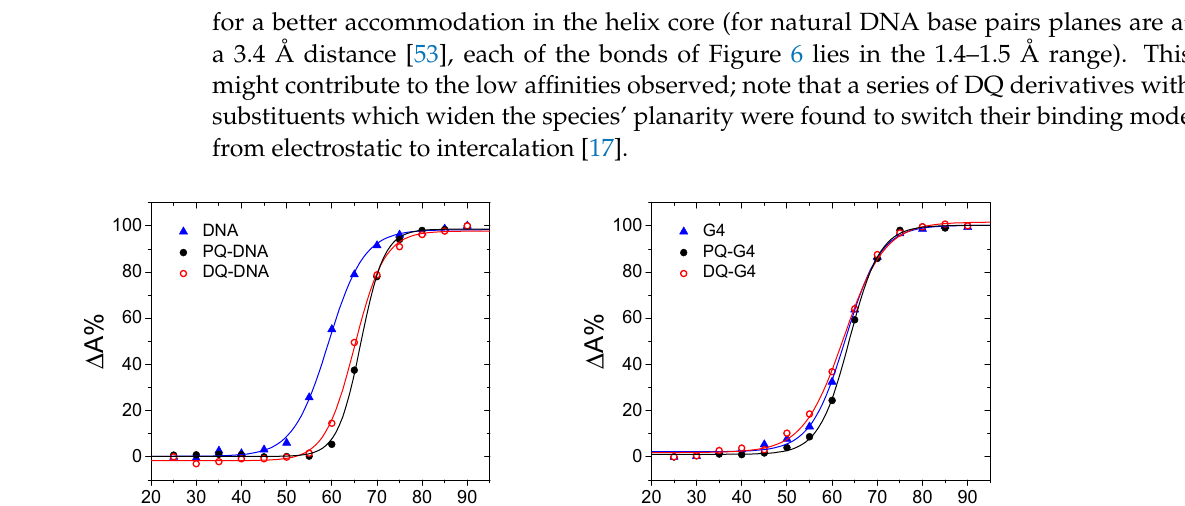
PQ DQ Figure 4. Relative viscosity vs. herbicide/DNA ratio (C D /C P ) for PQ (full mark) and DQ (open mark); C DNA = 1.77 × 10 − 4 M, C PQ from 0 to 1.92 × 10 − 4 M, C DQ from 0 to 2.0 × 10 − 4 M, NaCl 0.1 M, NaCac 2.5 mM, pH 7.0, 25.0 °C.